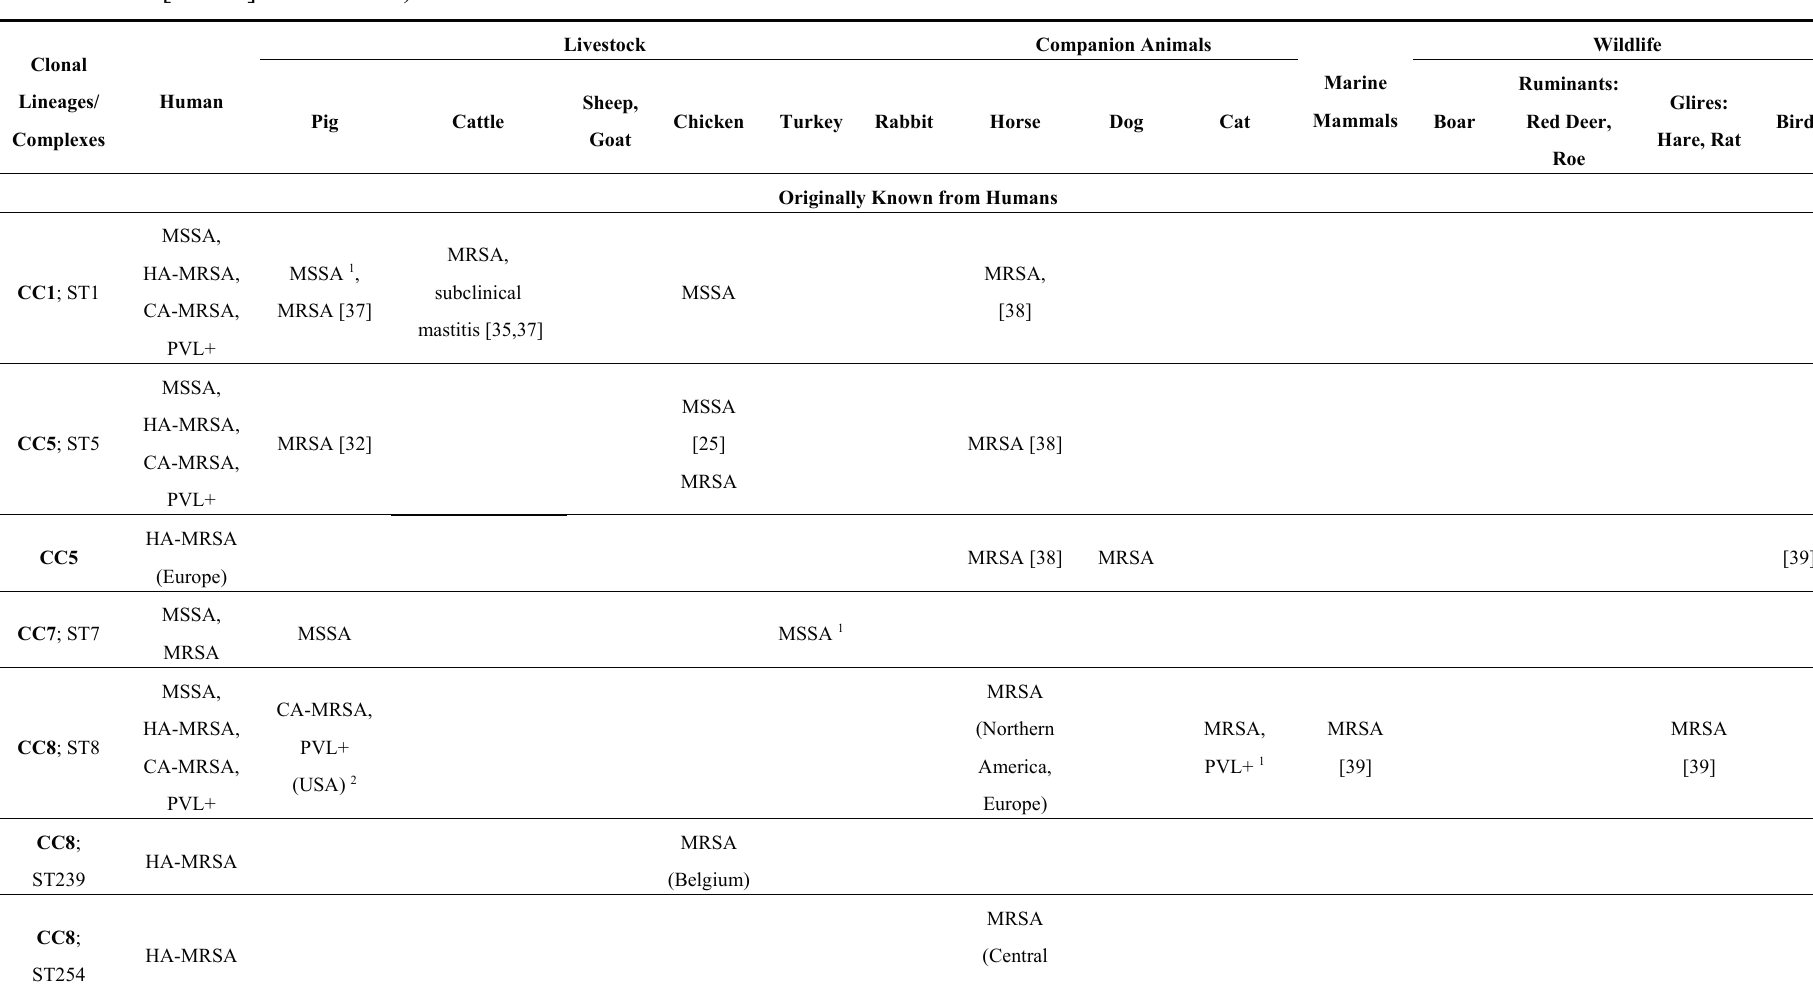
Table 1. Clonal lineages (ST) and clonal complexes (CC) of S. aureus observed in humans as well as in animals (references not covered by reviews [21–23] are